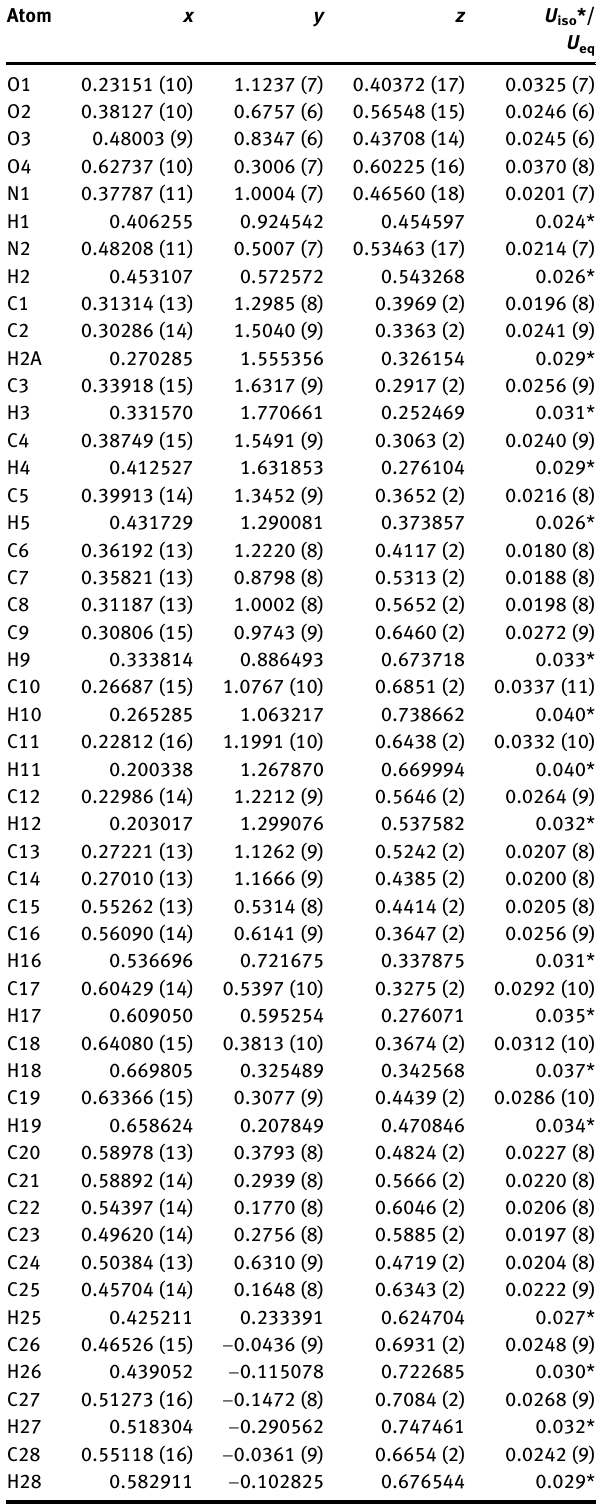
Table  : Fractional atomic coordinates and isotropic or equivalent isotropic displacement parameters (Å 